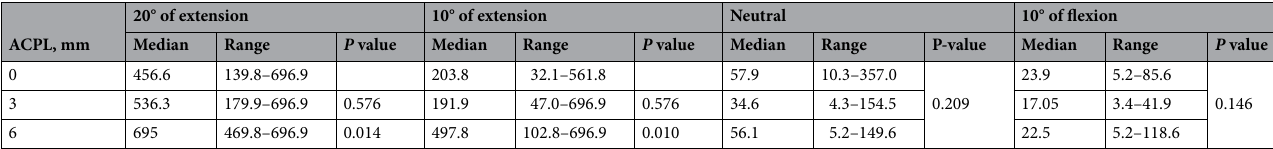
Table 1. Maximum surface pressure (kPa) of the iliopsoas muscle when ACPL was changed. Values are shown as the median and range. P value are from the Friedman test. For p values of < 0.05 in the Friedman test, the individual p values are shown for comparison with 0 mm based on the results of the post hoc test. ACPL, anterior cup protrusion